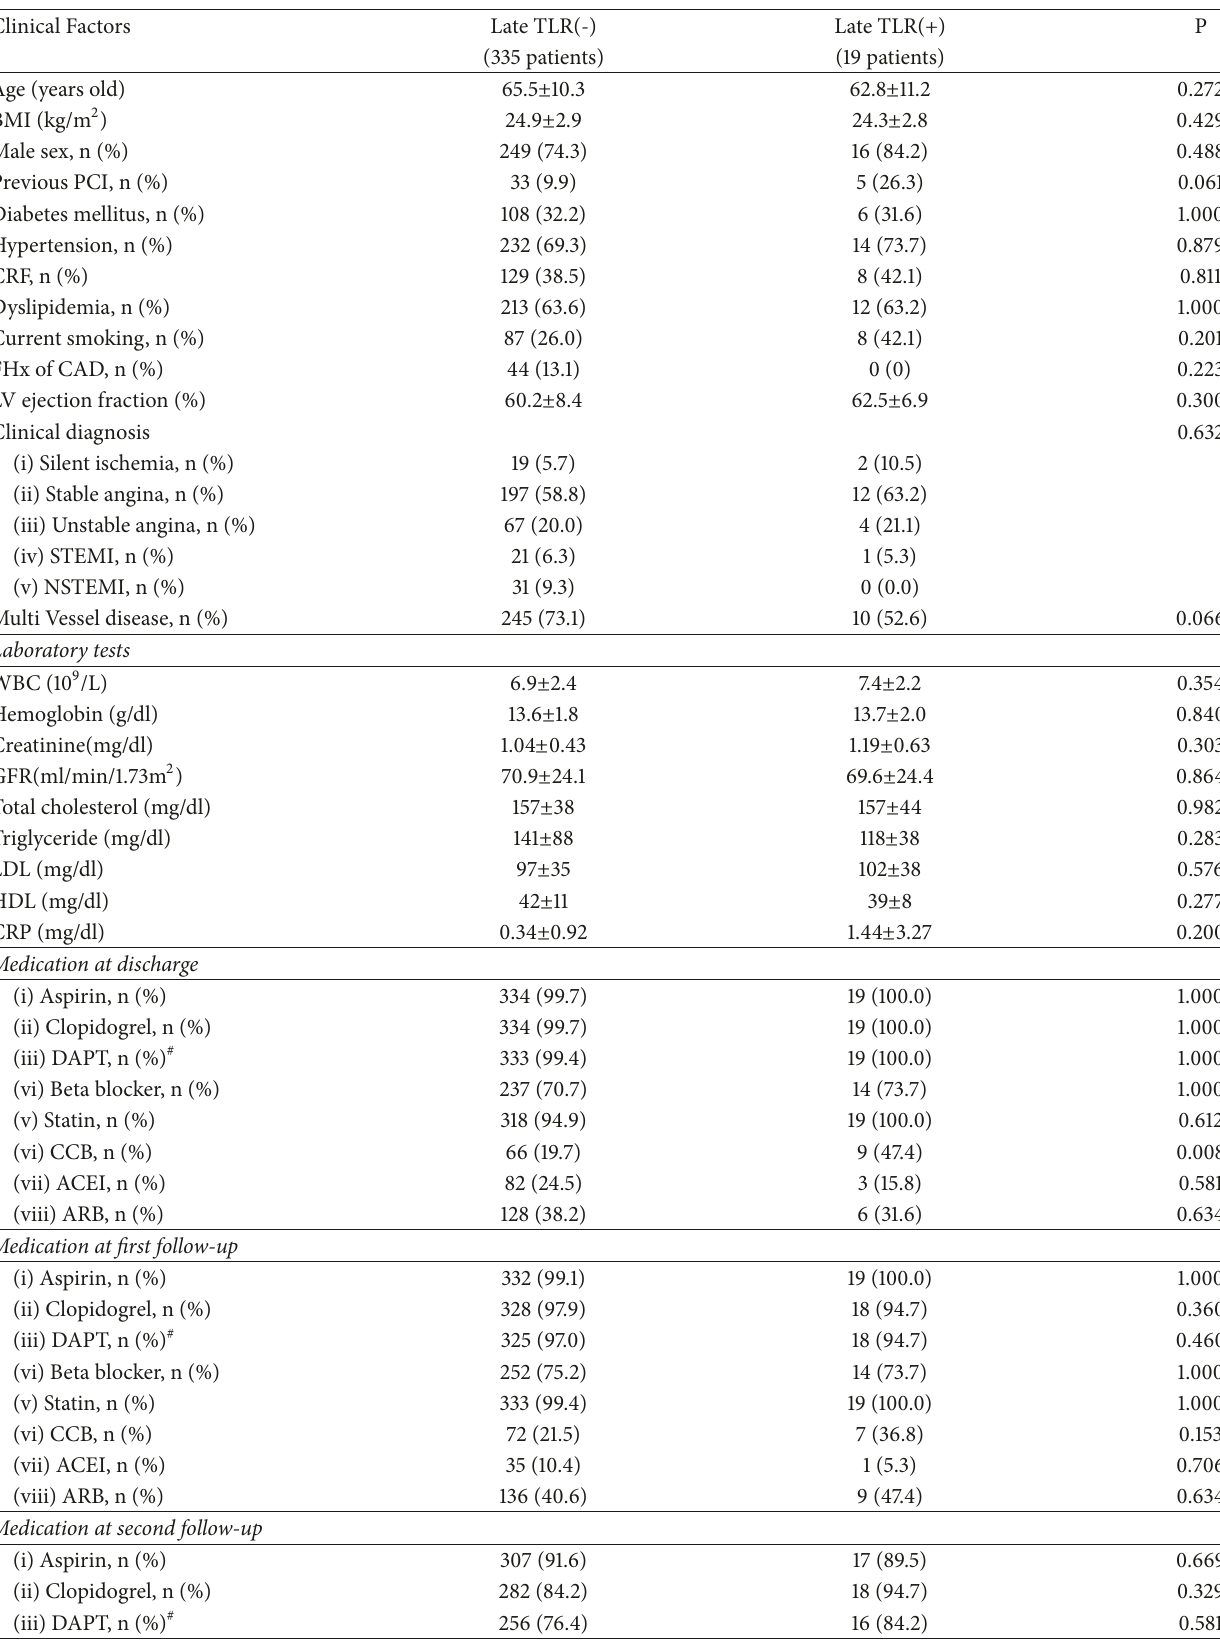
Table 2: Baseline patients and lesion characteristics according to late